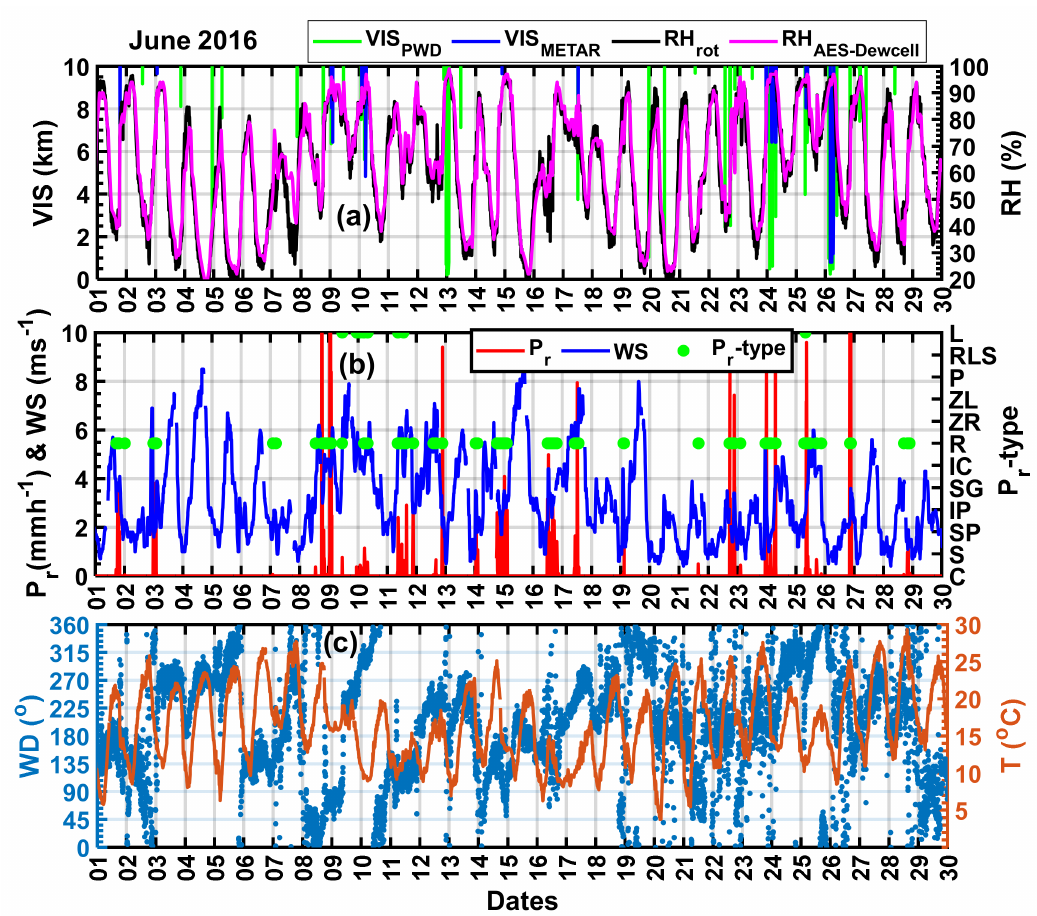
Figure 4. The same as Figure 3, but for the June